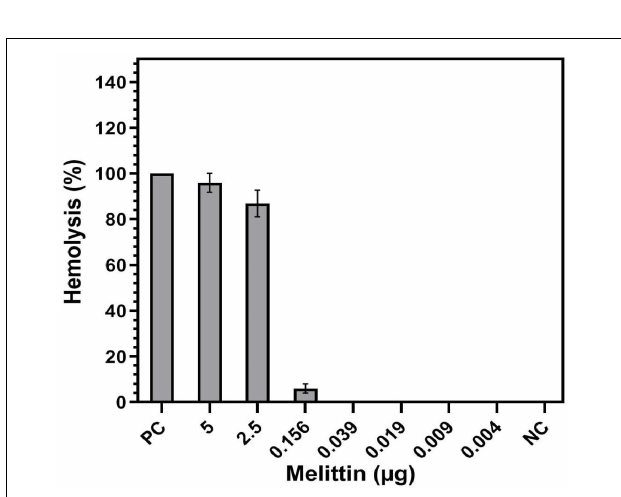
FIGURE 4 | Hemolysis of melittin alone and in synergistic concentrations toward human Red blood cells (RBCs). PC, positive control; NC, negative